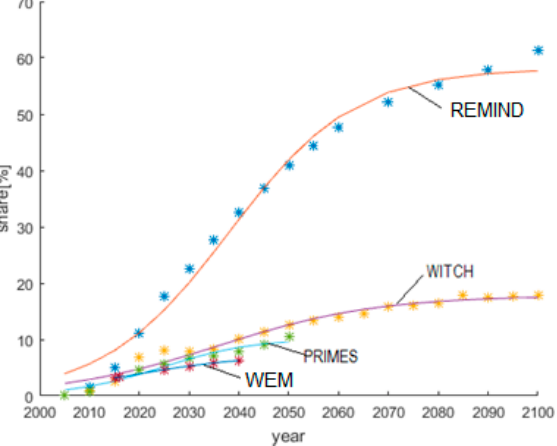
Figure 12. Reference scenarios for WEM, WITCH, PRIMES and REMIND programs for Europe’s solar PV power energy generation share (own work).